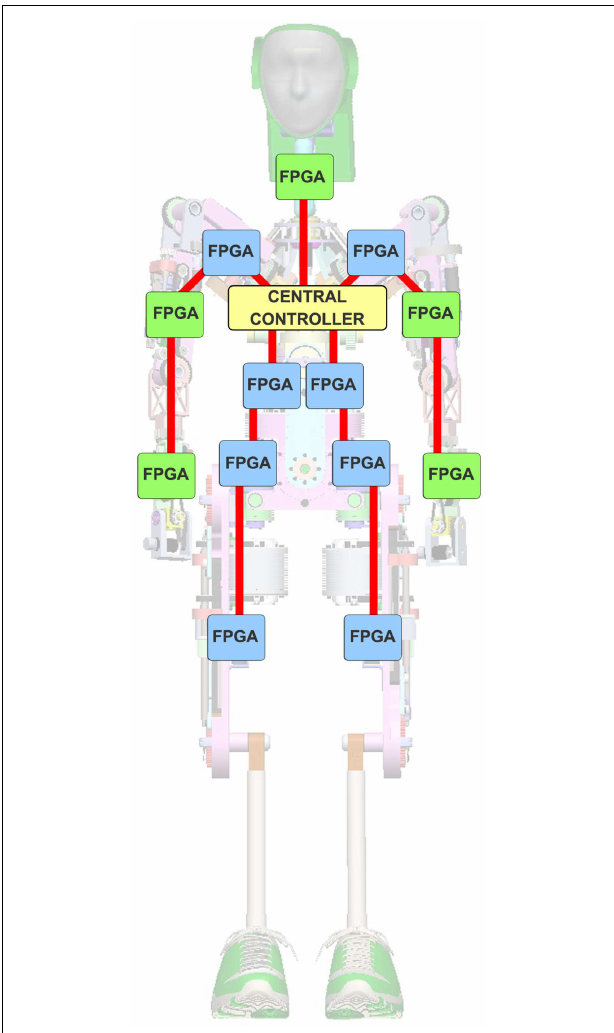
FIGURE 8 | Overall system design . The blue FPGA squares are the high-current BLDC controllers. The green squares are the low amp BLDC controllers. The red lines are bi-directional high speed communication fiber optic channels. The yellow square is the central